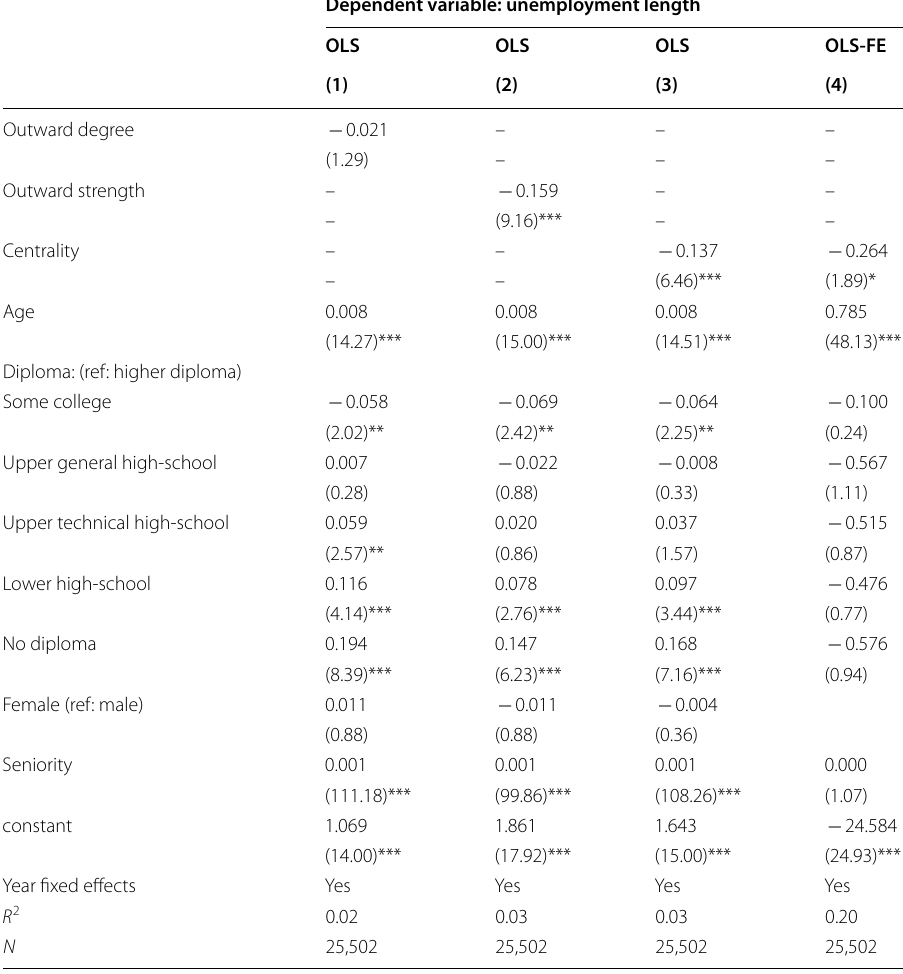
Table 5 Correlation between last occupation centrality and unemployment